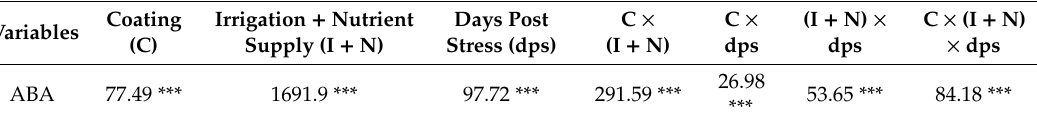
Table 4. Result of three-factor ANOVA for abscisic acid (ABA) in coated control plants and plants coated with thyme oil grown under moderate water / nutrient stress and short-term severe water / nutrient stress. The F values are shown, and the symbols indicate statistical significance (*** p < 0.001).